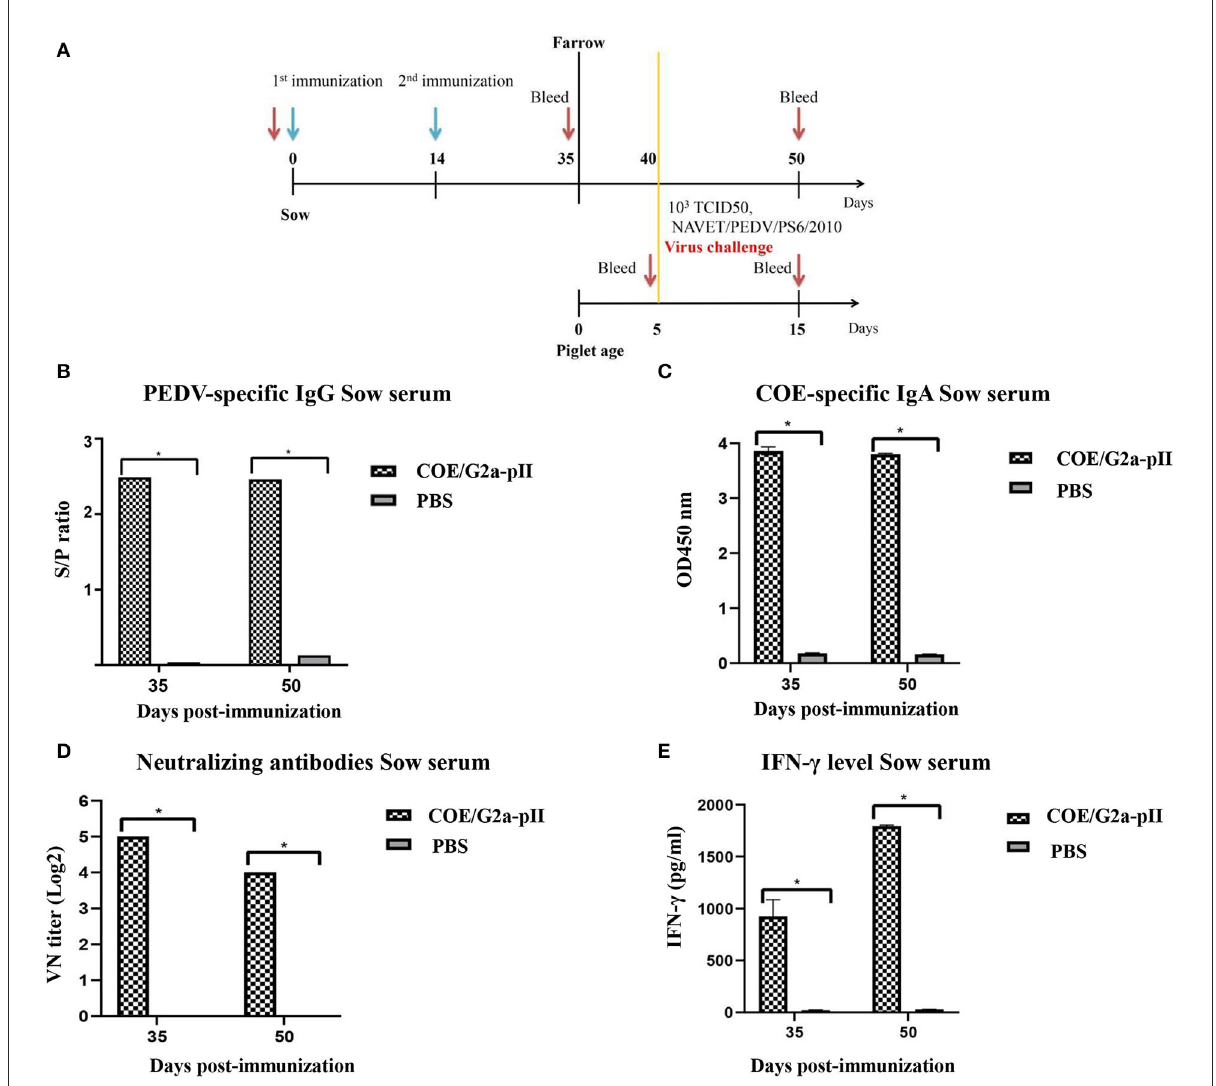
FIGURE2 Humoral immune responses and cytokine responses in pregnant sows. Data are presented as mean ± standard deviation (SD). * indicates a statistically significant difference ( p < 0.05). (A) Immunization and challenge experiment scheme in pregnant sows ( ∼ 80 days of gestation, n = 1 per group) and piglets ( n = 8 for COE/G2a-pII group and n = 2 for PBS group). The green arrow and red arrow indicate immunization and bleeding time, respectively. (B) PEDV-specific IgG antibodies in sow sera vaccinated with COE/G2a-pII or PBS were measured by a commercial ELISA kit. An S/P ratio > 0.35 was defined as positive with PEDV-specific IgG antibody. (C) COE-specific IgA antibodies in sow sera were evaluated by an ELISA using SEC-purified COE/G2a-pII as antigen. (D) Neutralizing antibodies in sow sera were analyzed by the virus-neutralizing assay. The highly virulent NAVET/PEDV/PS6/2010 strain (200 TCID50/0.1ml) was used for the assay. A VN titer ≥ 8 was defined as positive with neutralizing antibody against PEDV. (E) IFN- γ levels in sow sera were measured based on the standard curve of